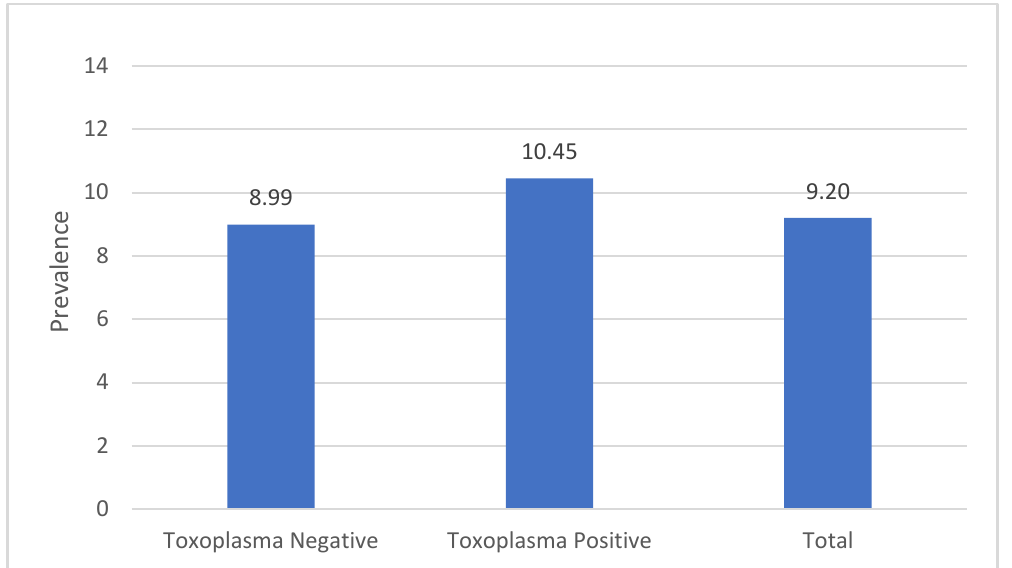
Figure 3. Age-adjusted prevalence of CKD by T. gondii exposure status. Total = T. gondii -positive and